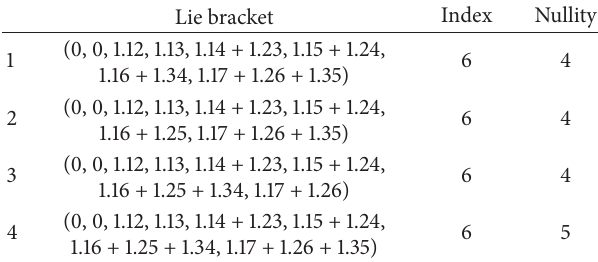
Table4:The8-dimensionalnilsolitonmetricLiealgebracandidates.